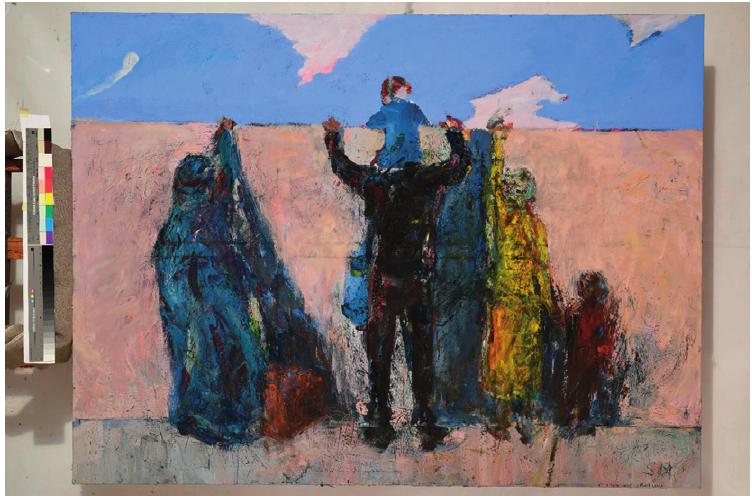
Figure 3. Sigita Maslauskaitė-Mažylienė. Border